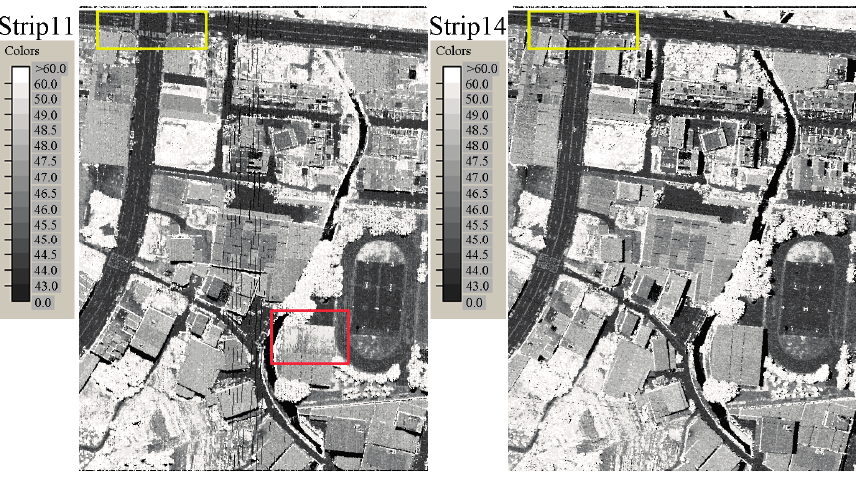
Figure 4. Width point cloud for four overlapping strips. The white markings on the road inside the yellow box and the roof inside the red box indicate that widths are slightly greater where strong amplitudes are present.